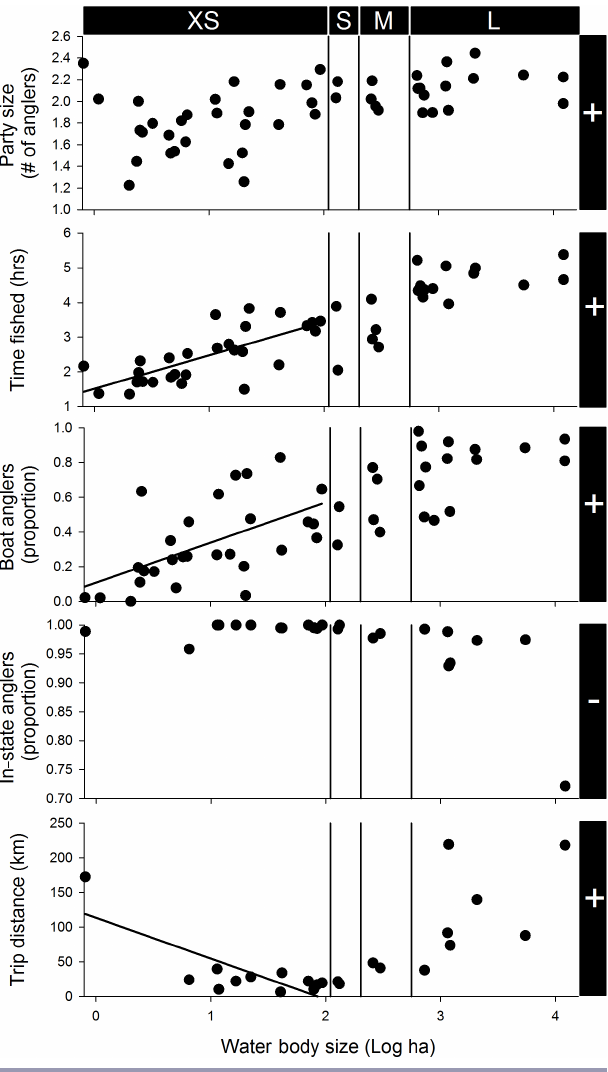
Fig. 5 . Bivariate plots between water body size (Log transformed ha) and catch attributes (each dot represents a single water body) across unscaled data (all water bodies) and scaled data (extra small and large water body groups). Water body groups (XS = extra small, S = small, M = medium, L = large) are listed at top and separated by vertical lines. Catch attributes include catch richness, fish harvested in catch, fish harvested, fish released, and catch rate. Significant relationships for unscaled data are depicted in the right black sidebar for each plot (positive relationship = +, negative relationship = -, no relationship = no sign). Significant relationships for scaled data are depicted by trend lines within each plot (no trend line = no